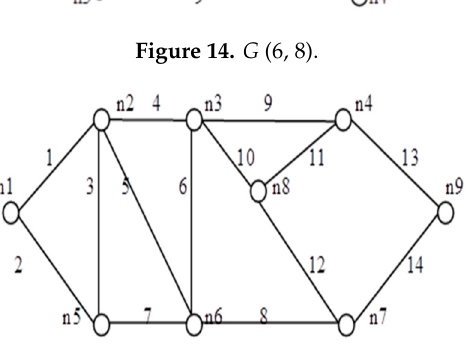
Figure 14. G (6, 8).